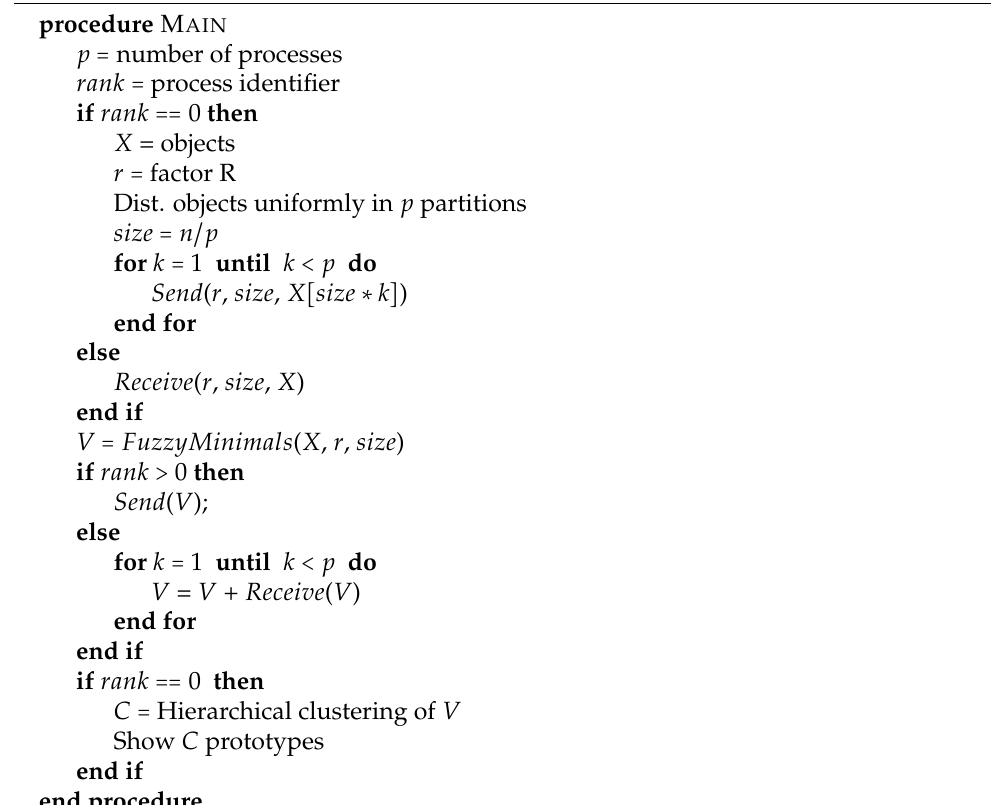
Algorithm 4 Main program in